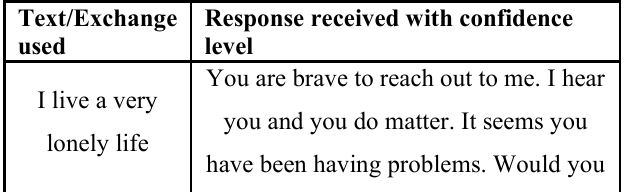
Table 16. Text samples ingested and the responses given out with the corresponding